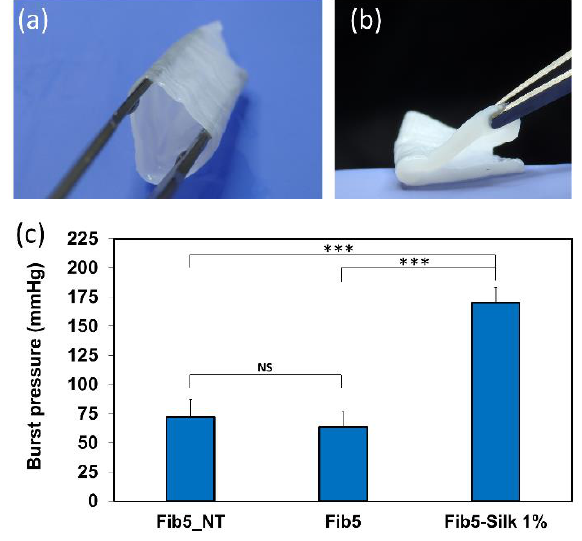
Figure 9. ( a ) Tubular scaffold of Fib5-Silk 1%. ( b ) Fib5-Silk 1% tubular scaffold collapsed under gravity, and further bended 180° on the circumferential axis. ( c ) Burst pressure values of the different scaffolds expressed as mean ± SD (*** p < 0.001; NS: not significant). The burst pressure of the composite Fib5-Silk 1% (170 ± 19 mmHg) was significantly higher ( p < 0.001) than those displayed by the scaffolds Fib5_NT and Fib5 (72 ± 15